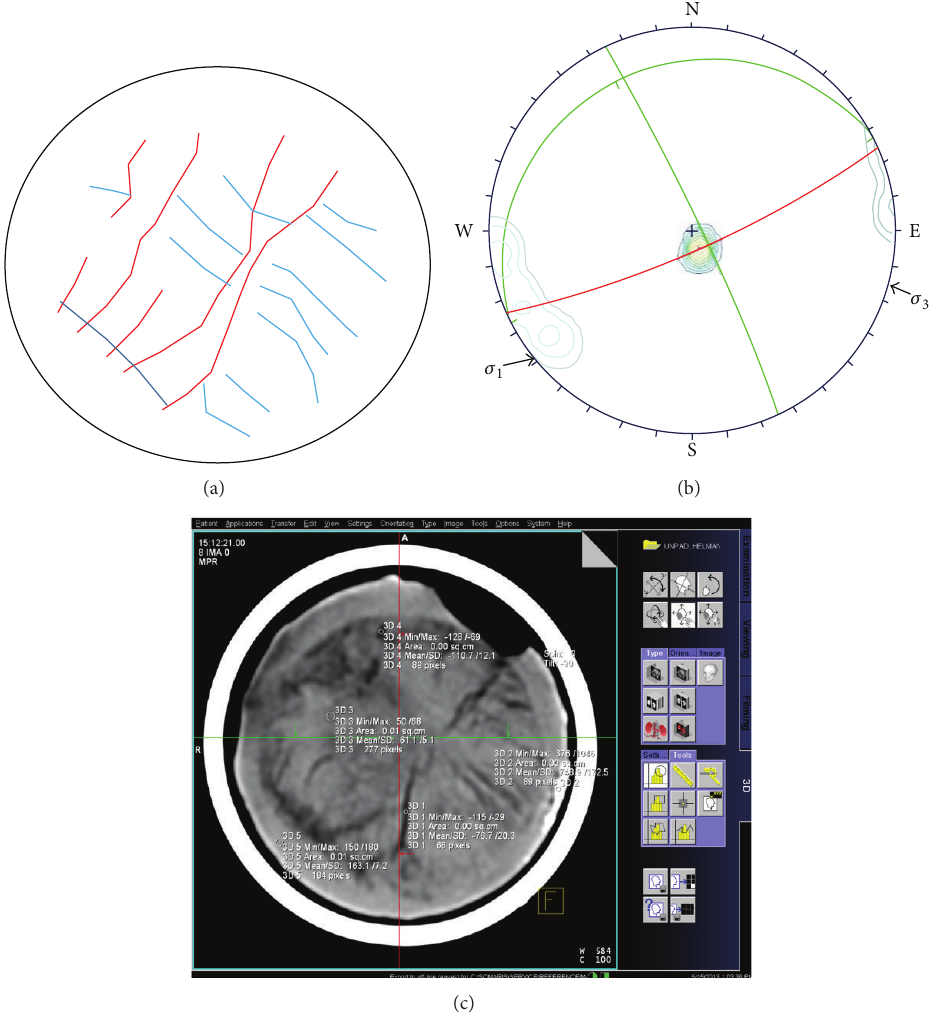
Figure 4: Slice image of SH-101A ( 𝑧 -axis direction), illustrating the CT cleat image (c), cleat interpretation and orientation (a), and Schmidt lower hemisphere equal projection net of cleats orientation relationships (b), showing that 𝜎 1 has NE-SW direction and its scale bar is 10mm. Two cleat orientations have been identified, that is, NNE-SSW direction (red color) and NW-SE direction (blue color). The cleats with NNE- SSW direction are abutting in the NE-SW